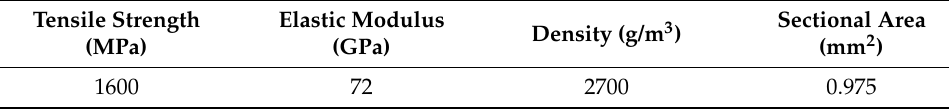
Table 2. Material properties of the alkali-resistant glass fiber.